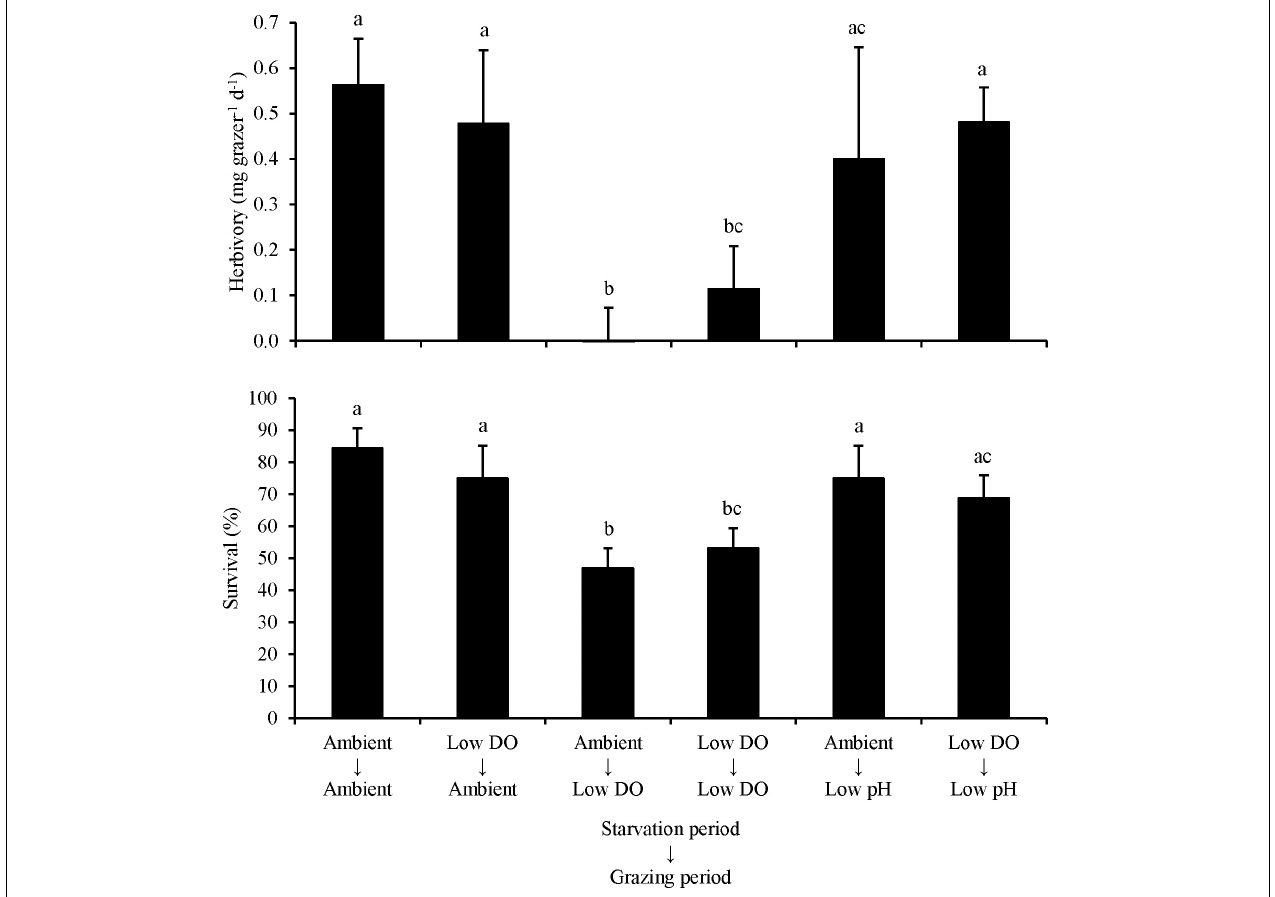
FIGURE 3 | Herbivory rates and survival of L. vincta grazing on U . rigida starved under ambient or low DO conditions and allowed to graze on U. rigida under ambient, low dissolved oxygen, or low pH conditions (Experiment 3; Table 2 ). Columns represent means ± standard deviation. Statistical analyses: Two-way ANOVA and post hoc Tukey Honest Significant Difference tests performed; significant differences between treatments represent p -values less than 0.05.